Question: Sum up the contents of this chart in one sentence.
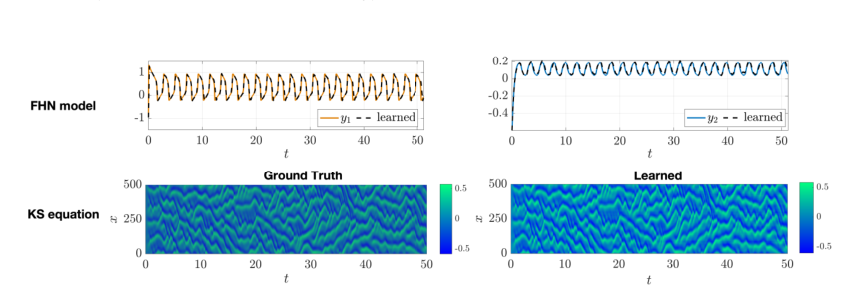
Answer: Performance of AHiTS on canonical PDEs